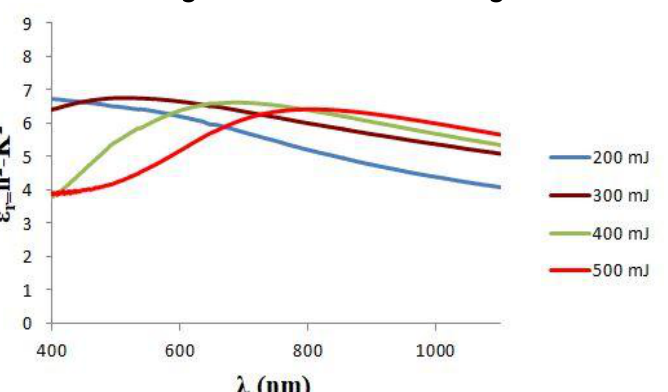
Fig.10: The variation of the dielectric constant real part (εr) of PbS nanostructure with wavelength for different laser energies